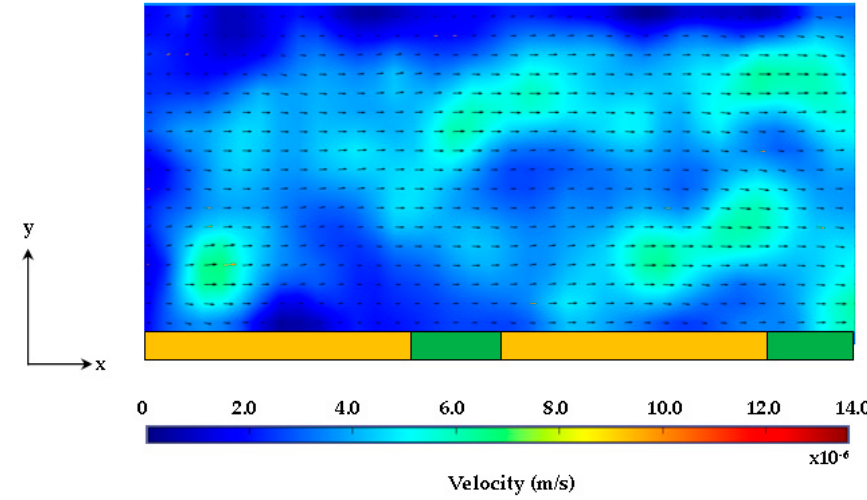
Figure 23. Velocity contour of 1 µm diameter particles under 750 mA and 10 Hz.